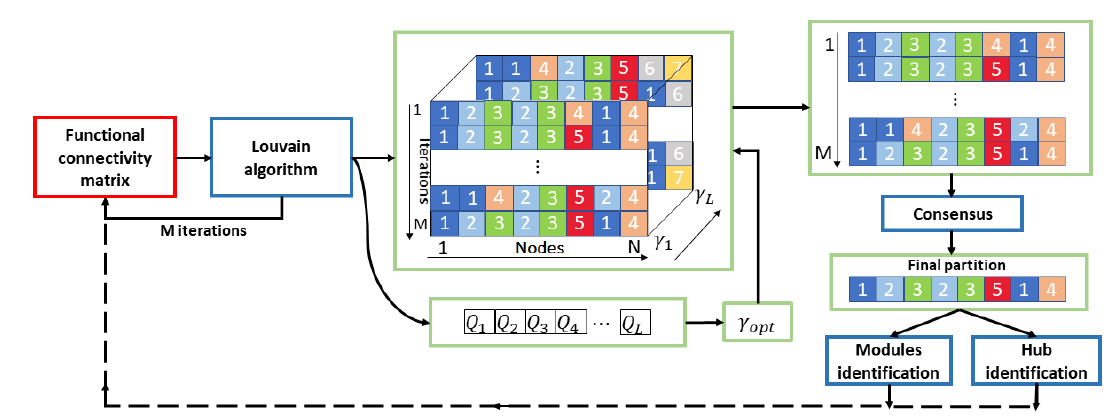
Figure 2. Flowchart of the modularity analysis. The Louvain algorithm is applied for M = 1000 iterations to each functional connectivity matrix for different values of γ . γ opt is the resolution value corresponding to the maximum Q value averaged over the M partitions. This procedure returns a set of different partitions corresponding to the optimal γ value. Hence, a consensus algorithm is applied to identify the most representative final community partition that is used to identify both the functional modules and the hub nodes of the